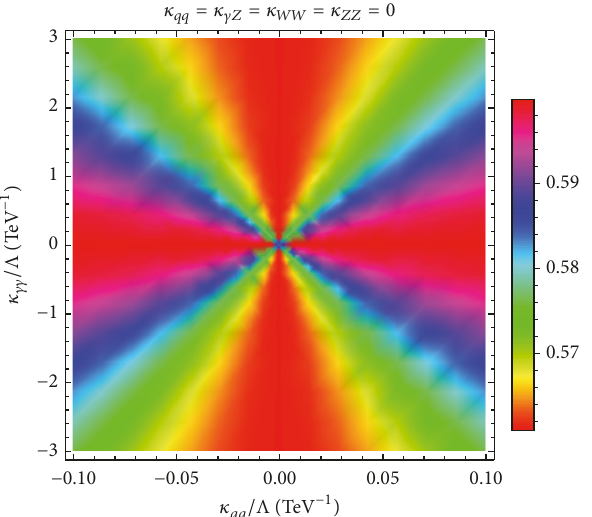
Figure 4: Combined cut efficiency in the 𝜅 𝑔𝑔 /Λ - 𝜅 𝛾𝛾 /Λ plane (all other 𝜅 𝑥𝑦 are zero) for 𝑀 Φ = 1 TeV for the ATLAS selection cuts as defined in the text.